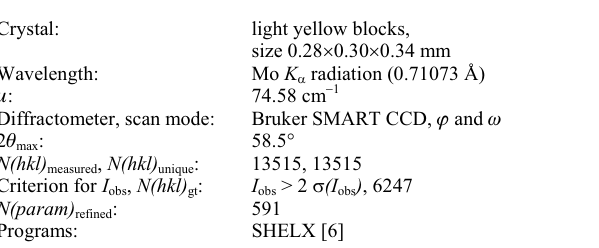
Table 1. Data collection and